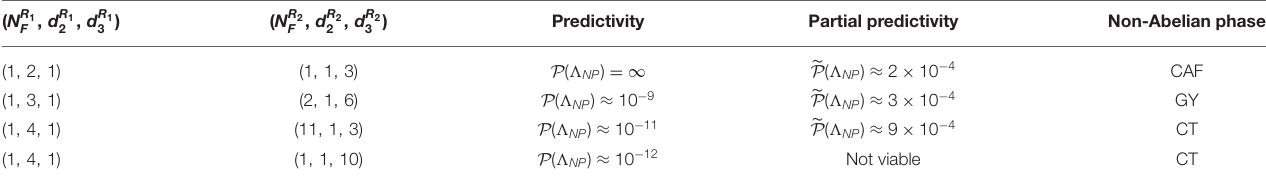
TABLE 2 | Preditictivity P ( 3 NP ) and partial predictivity characterized by their BSM matter content in the first two columns, see main text for further discussion.